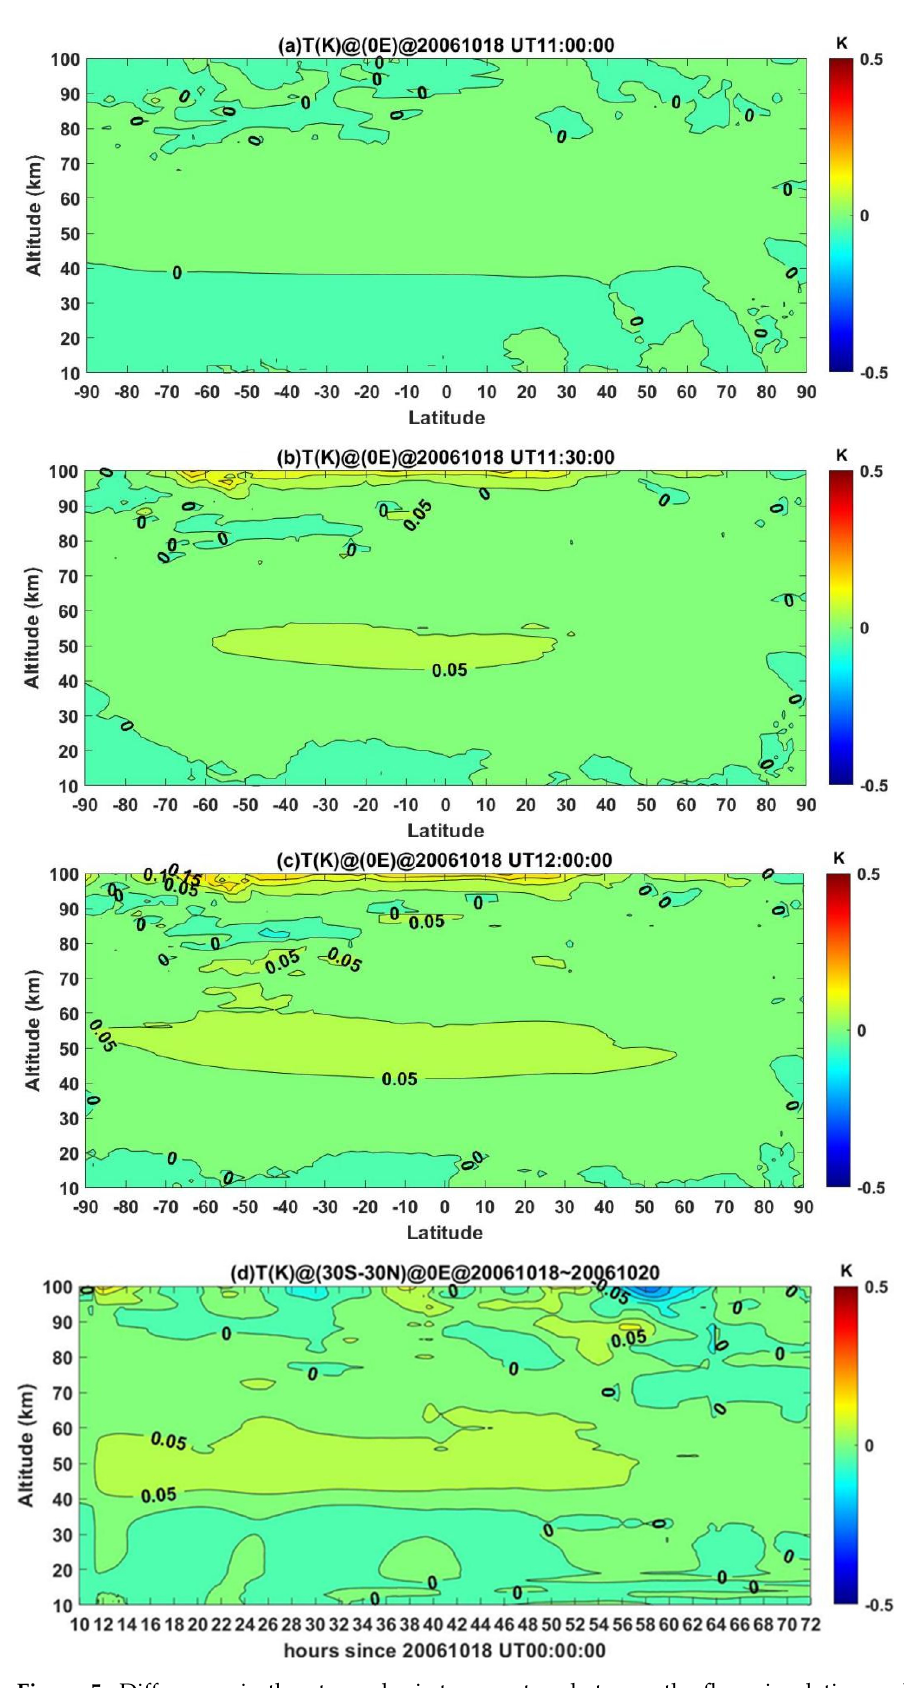
Figure 5. Differences in the atmospheric temperature between the flare simulation and baseline simulation. (( a – d ); flare simulation minus baseline simulation).